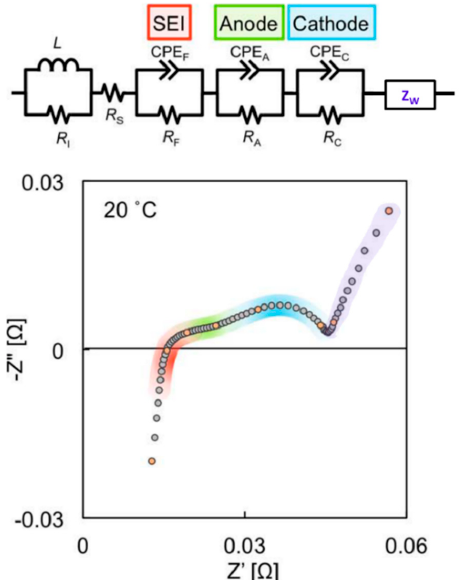
Figure 9. Example of impedance spectrum and fitted equivalent circuit of commercial LIB. Circuit